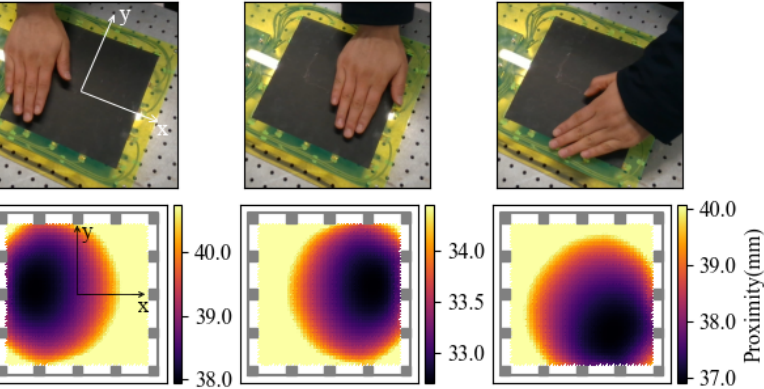
Figure 6. Proximity reconstruction results under three different hand-hovering conditions. A thresh- old of 80% value between the minimum and maximum proximity value is applied.